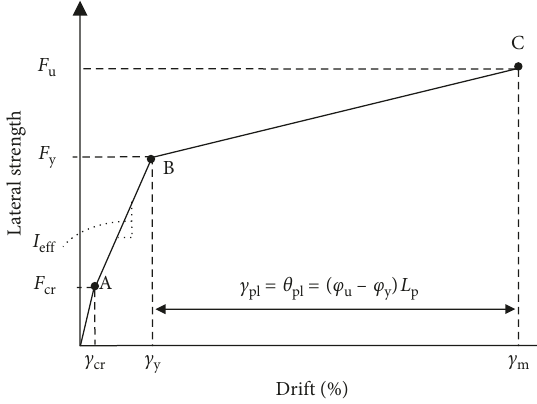
Figure 9: The backbone curve model of lateral load-drift capacity [20].